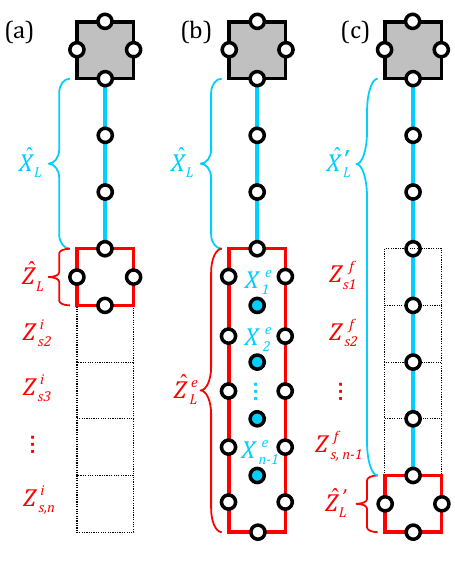
Figure 34: Moving a Z-cut qubit hole through multiple cells. The X line linking the logical qubit holes and passing through the data qubits (open circles), and the Z loop is in red (gray). The upper (gray) and lower (white) Z-cut holes enclose idle Z L stabilizers; the outlines have measure-X qubits on the vertices with data qubits on the edges. (a) Initial state, showing the logical operators X corrected Z stabilizer measurement outcomes Z i